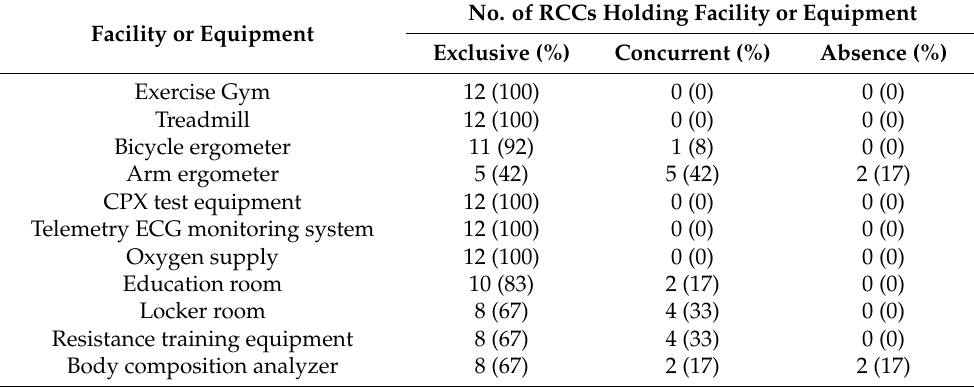
Table 5. Facility and Equipment for Cardiac Rehabilitation Program in 12 RCCs.